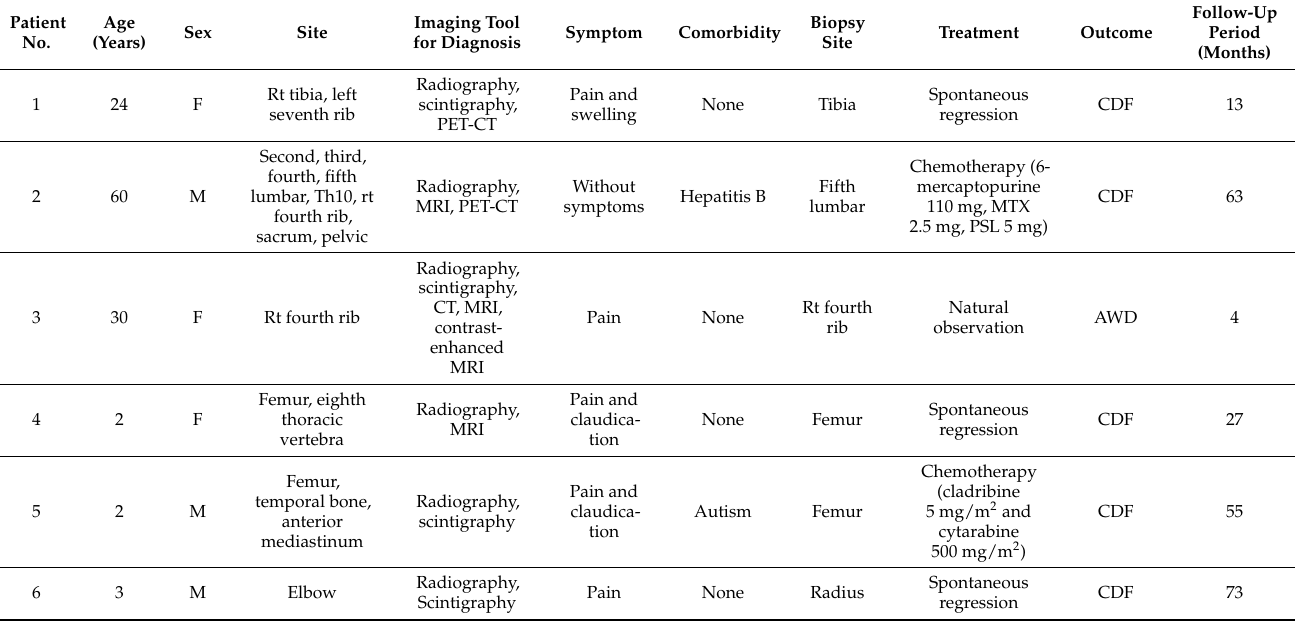
Table 1. Clinical features of Langerhans cell histiocytosis (LCH) cases in the current study. Patient